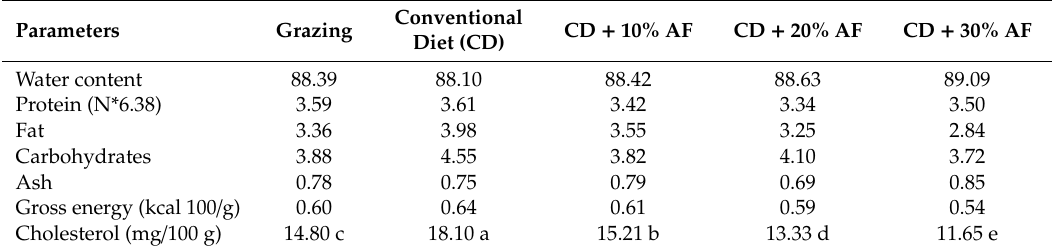
Table 2. Goat’s milk chemical composition (g / 100 g) from semiarid systems in Mexico. AF = Acacia farnesiana